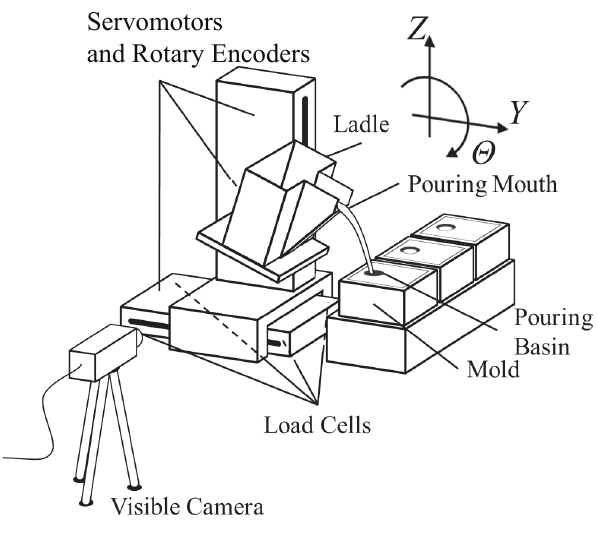
Figure 1. Automatic pouring